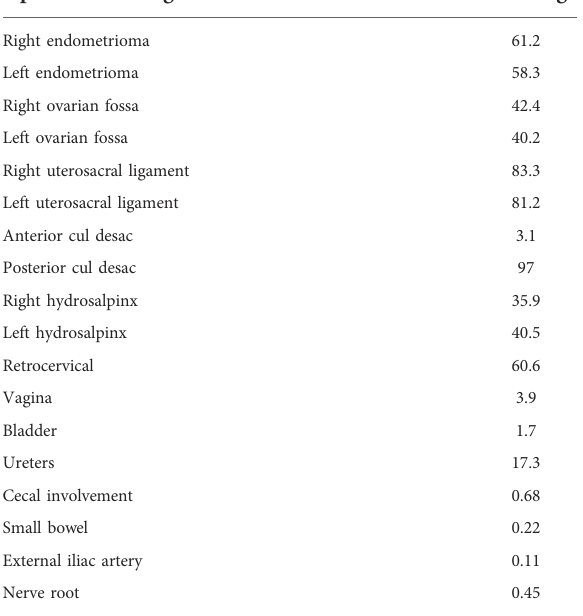
TABLE 2 Percentage of endometriosis involvement in different parts of the pelvis simultaneously with colorectal endometriosis according to histopathologic fi